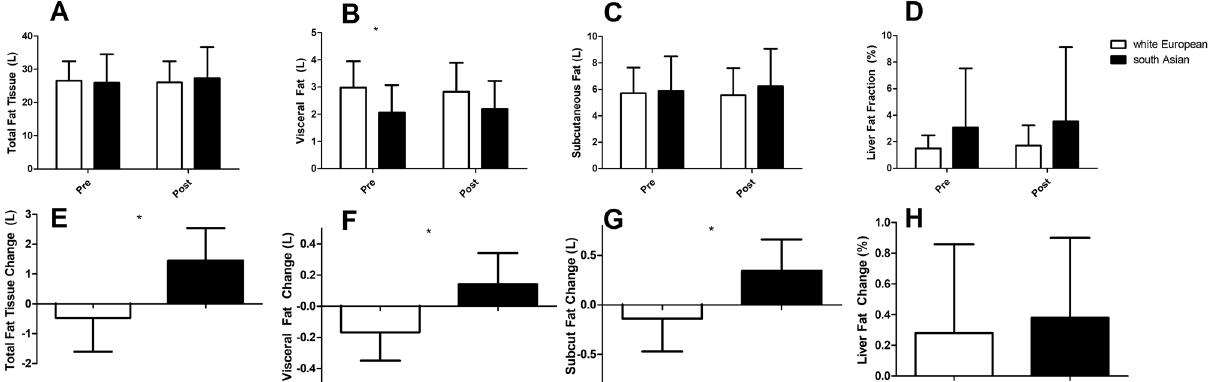
Figure 2. Fat tissue responses to 12 weeks of resistance exercise training in white Europeans and south Asians. Changes are adjusted for age and baseline values for that variable and are presented as mean (95% CI). *Denotes a significant difference between ethnicities in response to resistance exercise training (ANCOVA). Subcut =